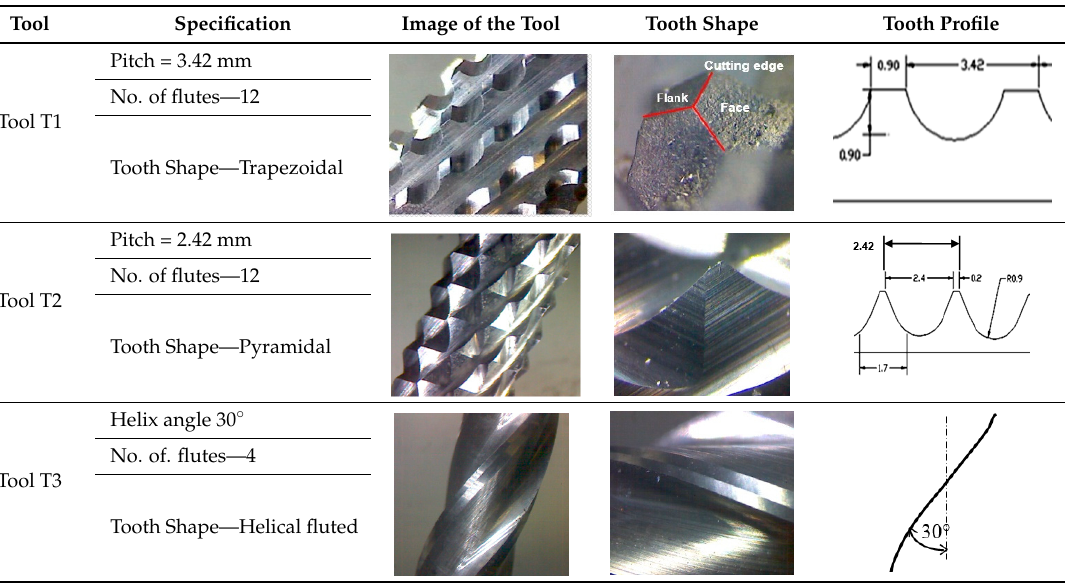
Figure 2. ( a ) Tool T1 ( b ) Tool T2 ( c ) Tool T3. Table 1. Cutting tools used and their specification.